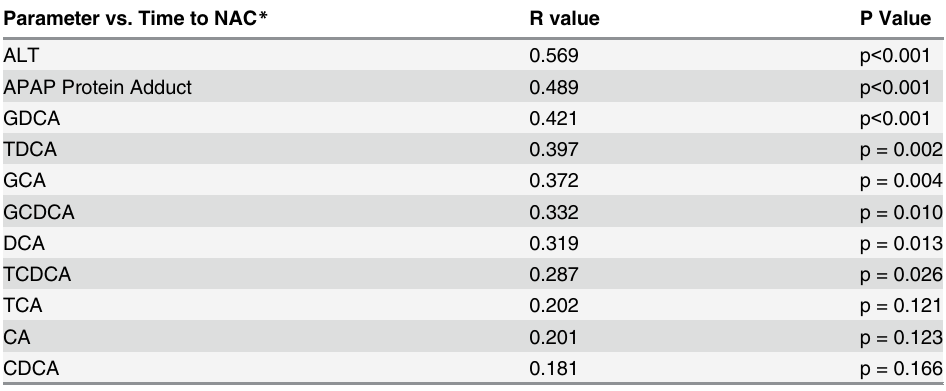
Table 3. Correlation analysis of peak biomarker versus time to treatment with N-acetylcysteine (NAC) *